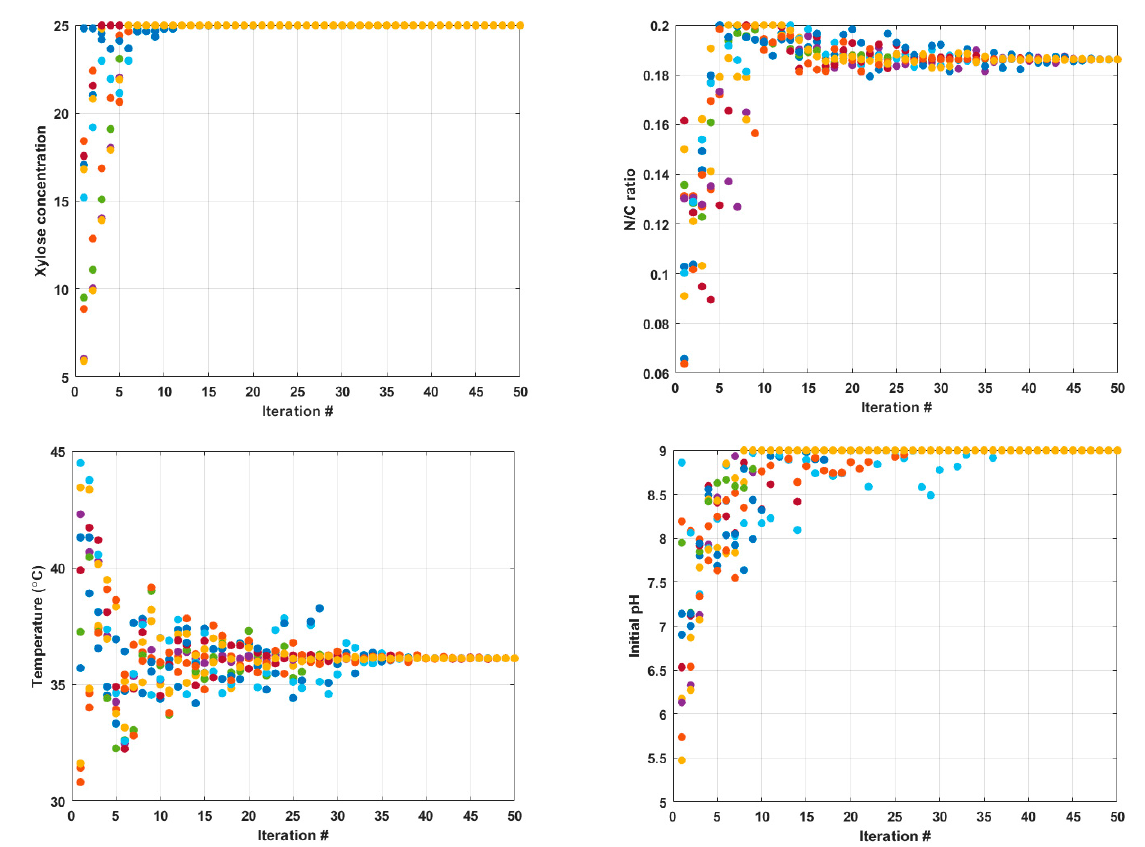
Figure 5. The distribution of 10 particles inside the search space matrix for xylose concentration, N/C ratio, temperature, and initial pH.